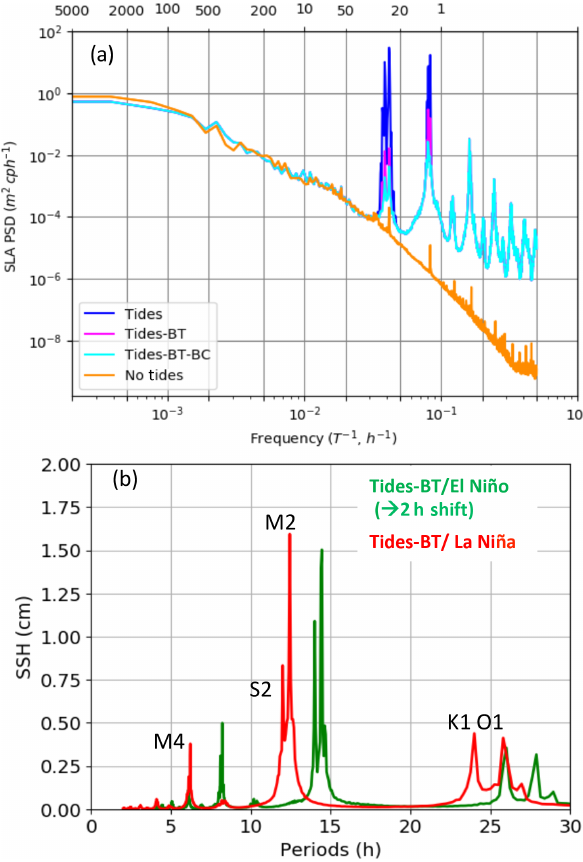
Figure 6. (a) SSH frequency spectra averaged over the Solomon Sea area based on the 3-month hourly outputs of the El Niño period for the R36h simulation (no tides, in yellow), for the R36Th sim- ulation including barotropic and baroclinic tides (Tides, in blue), baroclinic tides only (Tides-BT, in pink), incoherent baroclinic tides only (Tides-BT-BC, in cyan). (b) Zoomed in on SSH frequency spectra showing the diurnal, semidiurnal, and quarter-diurnal sig- nature of baroclinic tides calculated during the El Niño period (in green) and the La Niña period (in red). For clarity the green spec- trum is shifted by